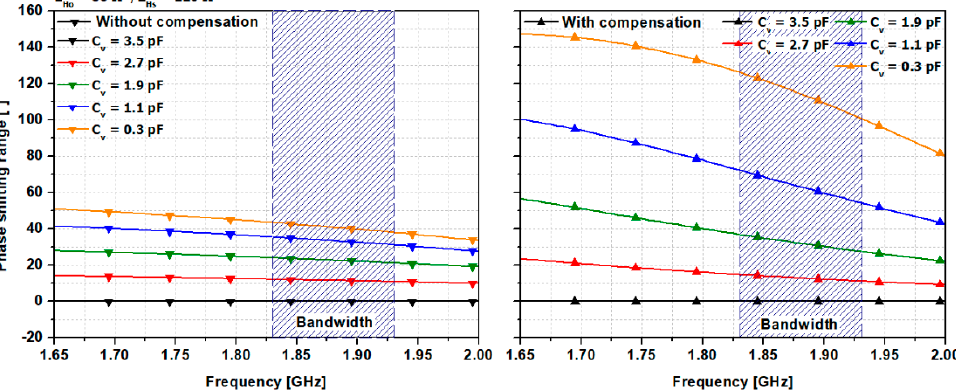
Figure 5. PSR with and without compensating for the effects of a of λ /4 shunt open stub at the low − band.